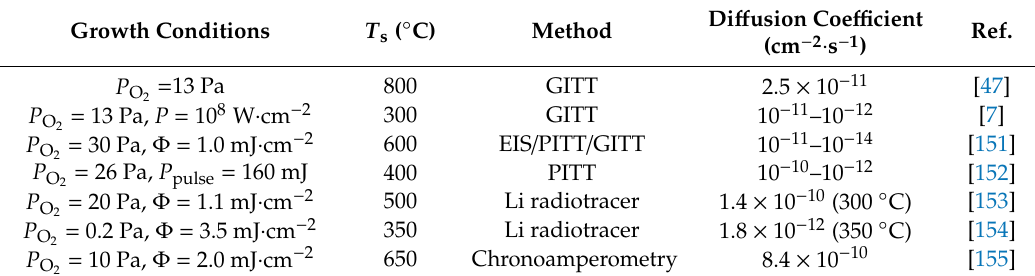
Table 5. Di ff usion coe ffi cients of Li + ions in PLD LMO thin film frameworks. Growth